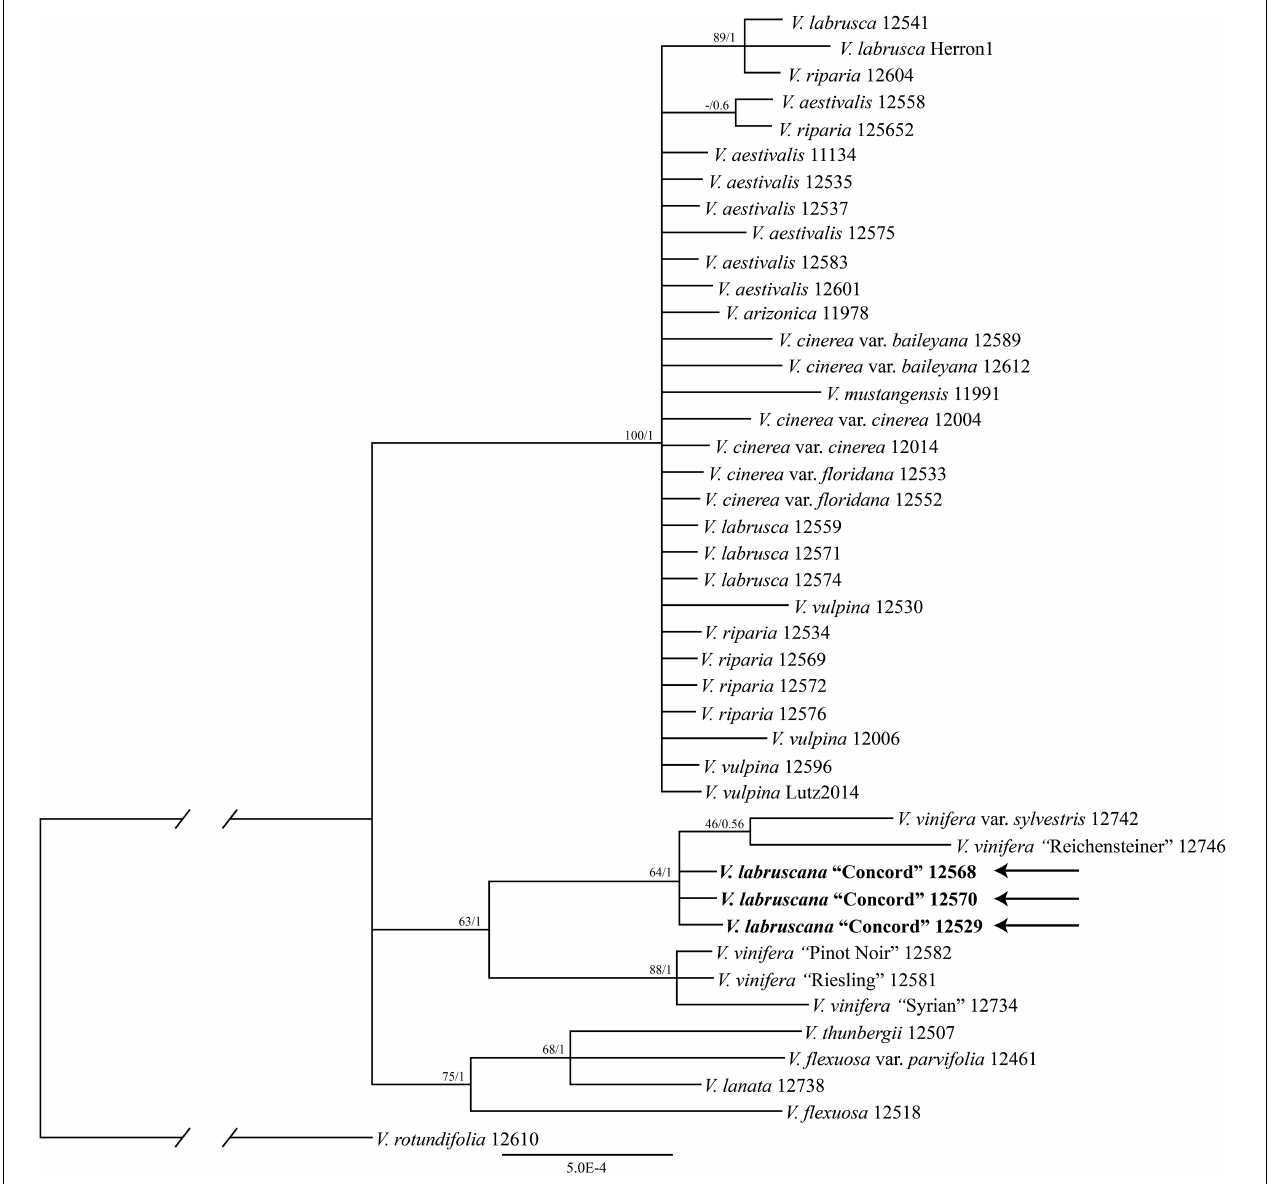
FIGURE 1 | Phylogenetic relationships of the Concord grape and its close allies in Vitis using combined chloroplast DNA marker sequences and Bayesian inference. Numbers associated with the branches are ML bootstrap support and Bayesian posterior probability